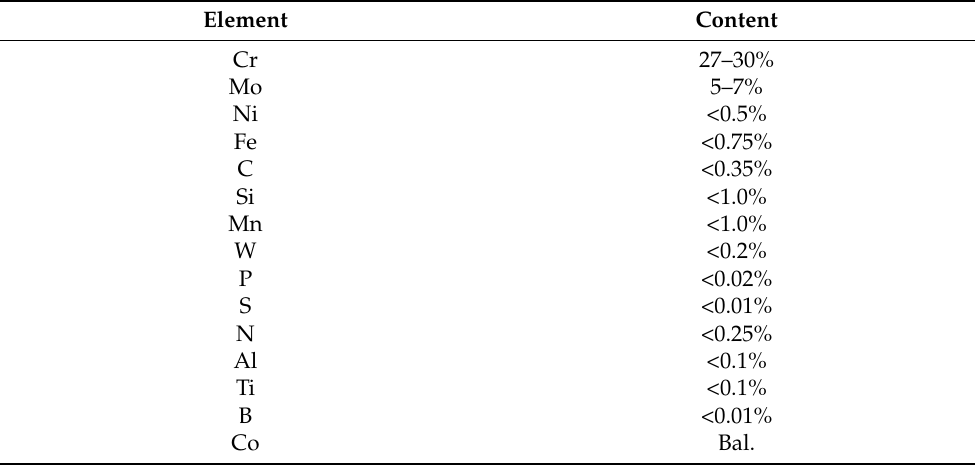
Table 2. Chemical composition of ASTM F75 Co-Cr